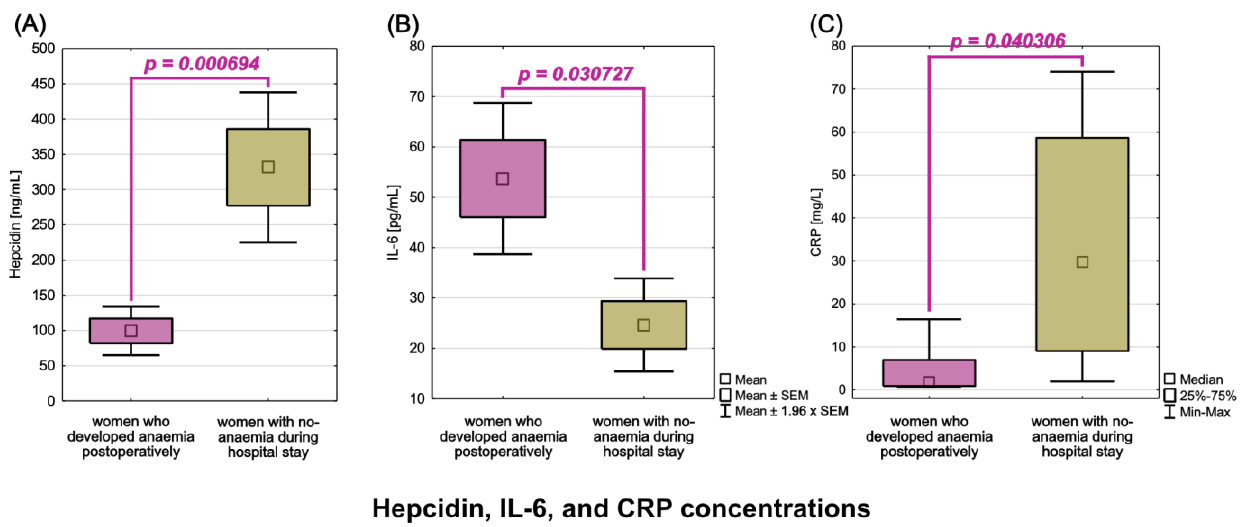
Figure 3. Hepcidin ( A ), IL-6 ( B ), and CRP ( C ) levels in women with and without post-operative